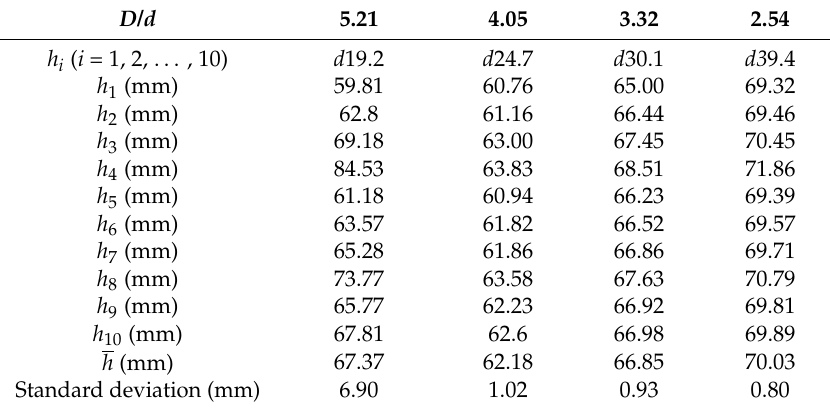
Table 7. Results of single particle tests.